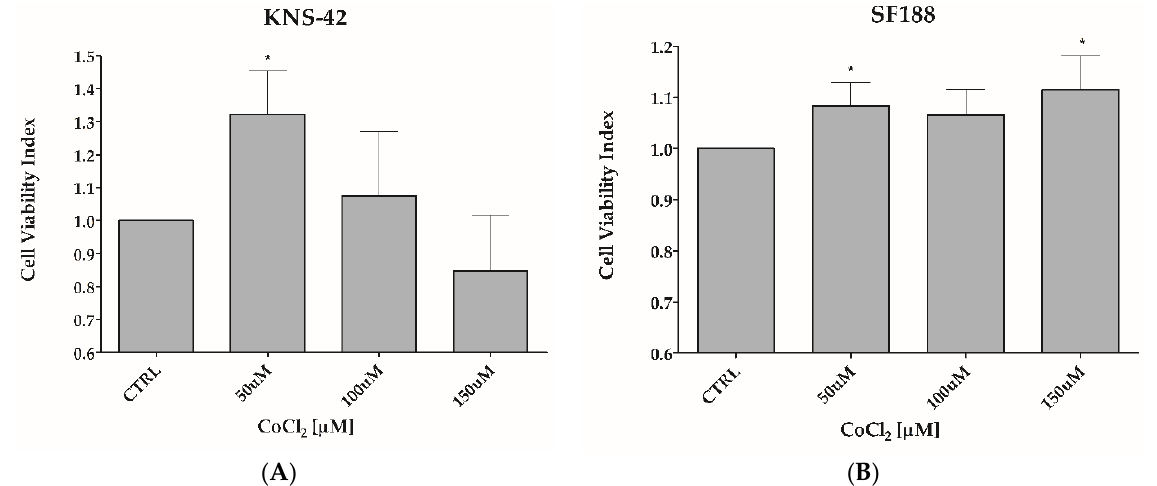
Figure 1. CoCl 2 treatment did not reduce the cell viability of pHGG cell lines. Analysis of cell viability of KNS-42 and SF188 cell lines when treated with different concentrations of CoCl 2 (50, 100, and 150 μ M) for 24 h. Viability was measured using the Resazurin method. * p < 0.05.